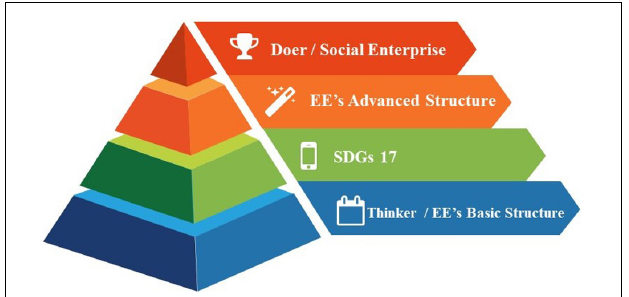
FIGURE 2 | Layers of the proposed CIE education framework (side